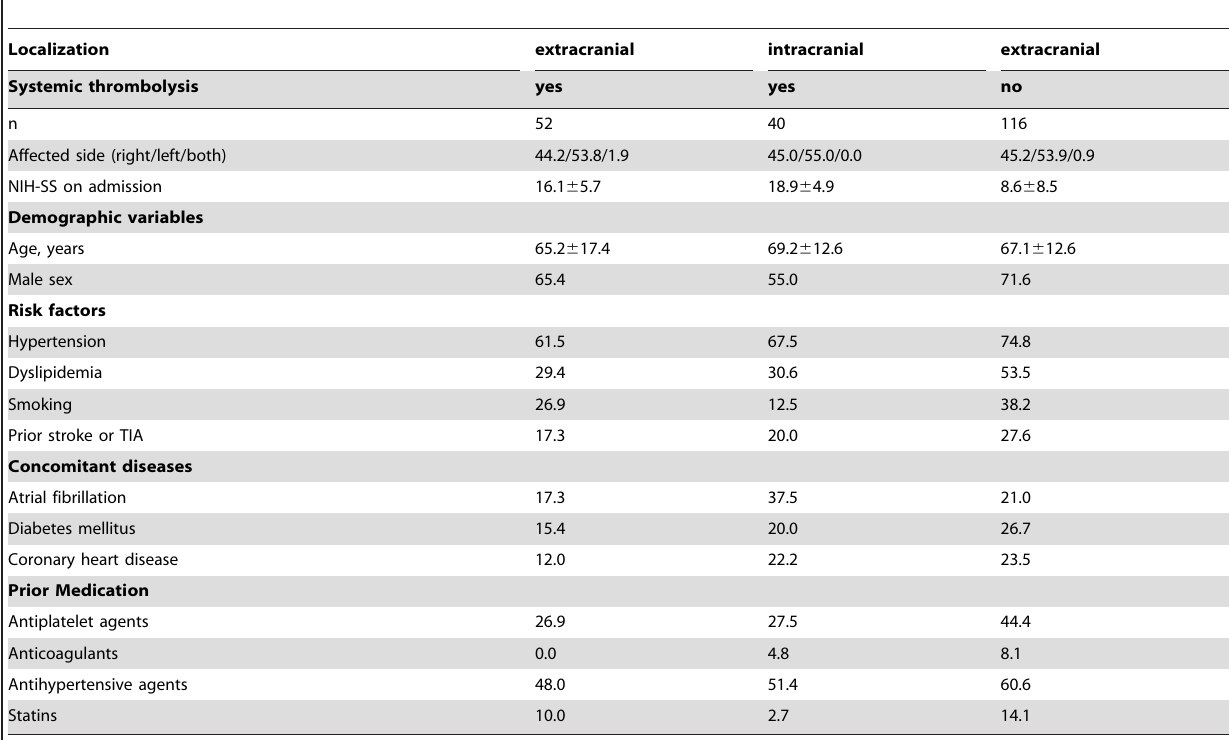
Table 1. Baseline characteristics of acute ischemic stroke patients with internal carotid artery occlusion grouped according to occlusion localization and administration of systemic